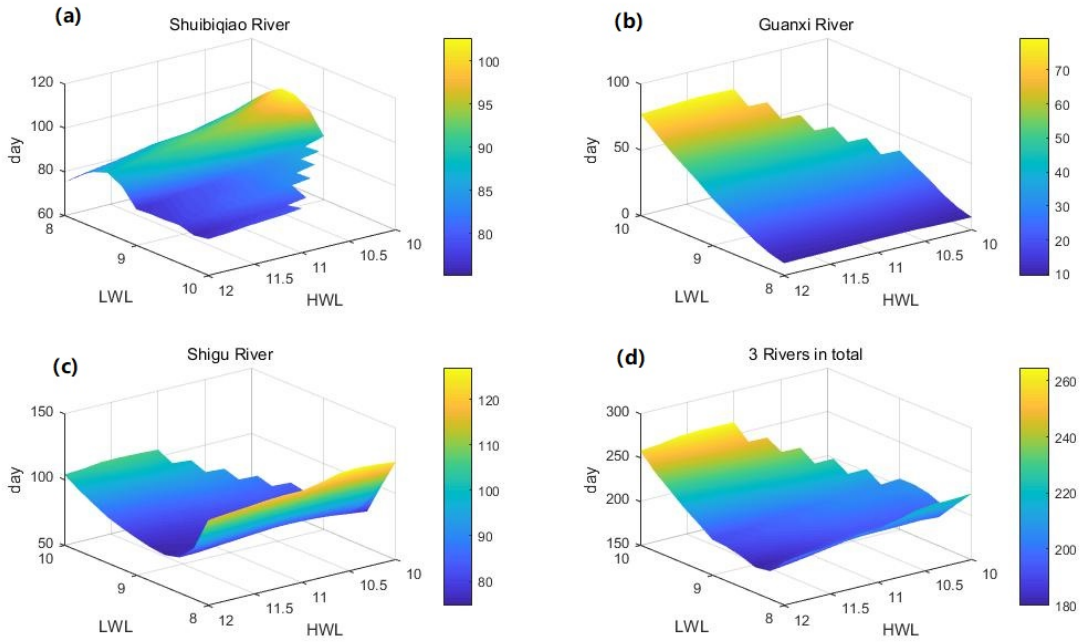
Figure 2. The mean annual number of days of unsatisfactory ecological flow of ( a ) Shuibiqiao River, ( b ) Guanxi River, ( c ) Shigu River and ( d ) Three rivers in total, under different regulation scenarios combined by LWL and HWL. Table 4. The number of unsatisfactory days of ecological flow under different regulation scenarios.